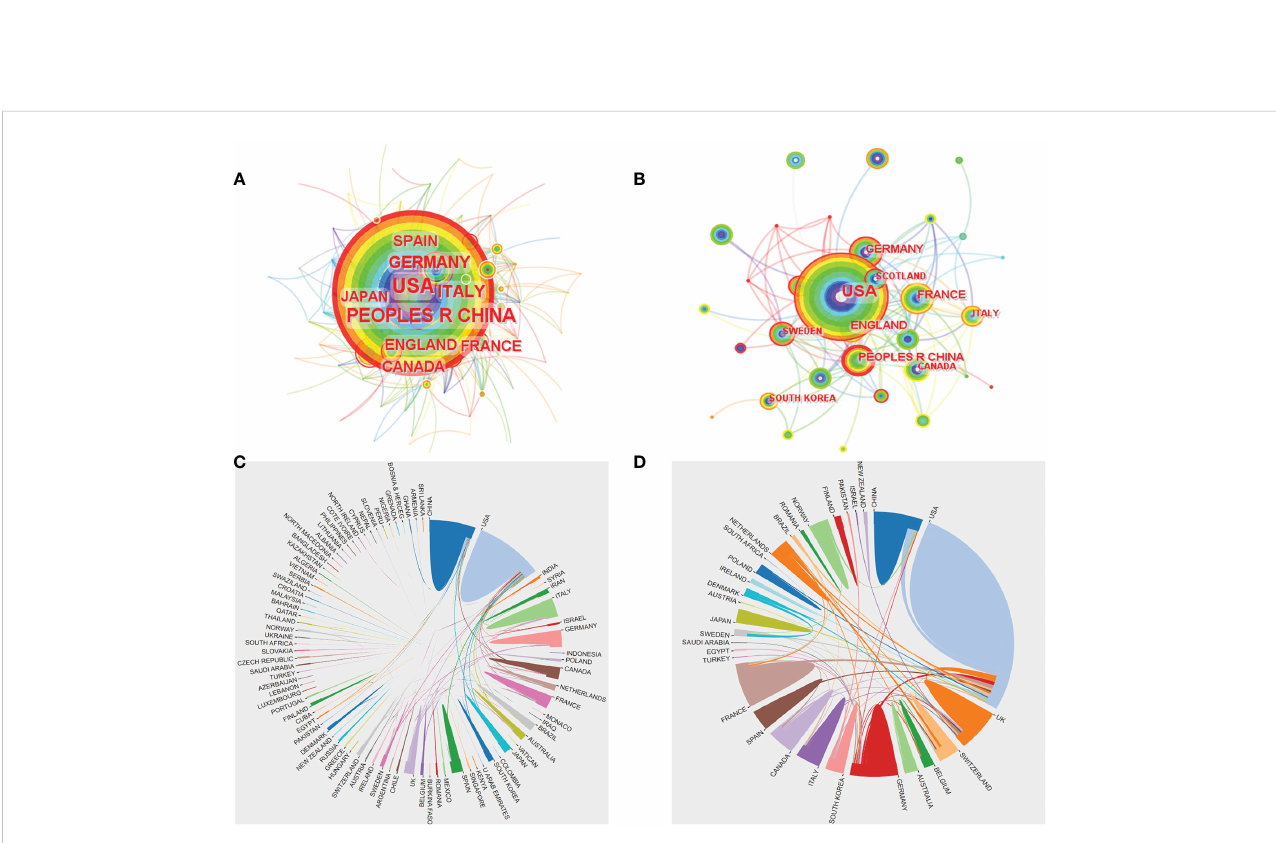
FIGURE 4 The co-occurrence of countries (A, B) and the cooperation relationship between countries (C, D) of relevant literature. ( A, C : all relevant literature; B, D : citation classics).